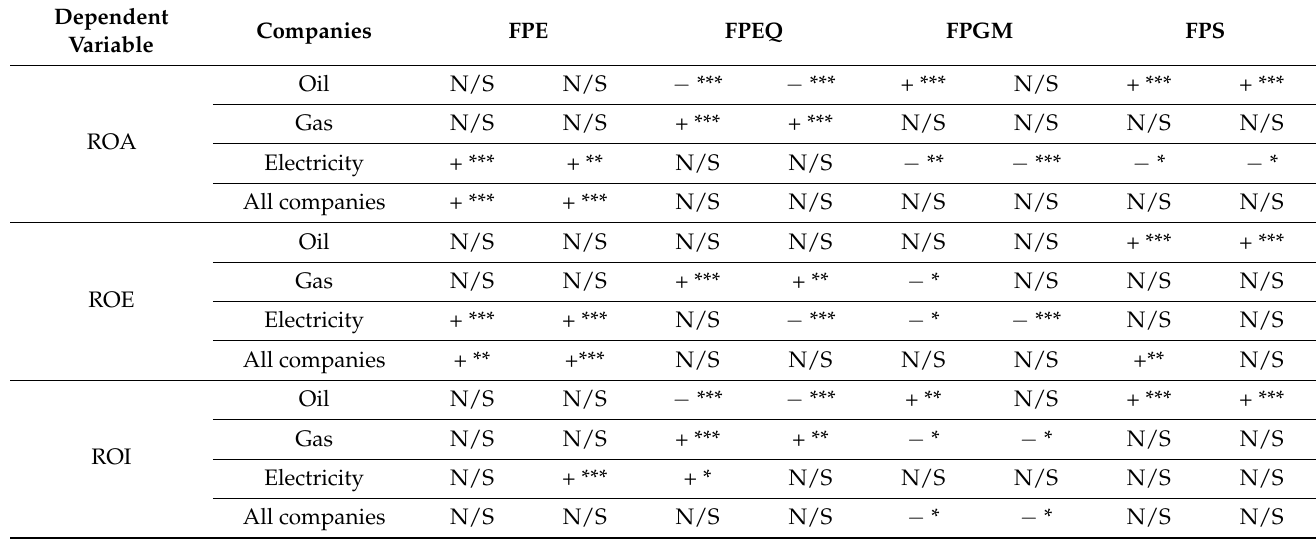
Table 15. Synthesis of empirical